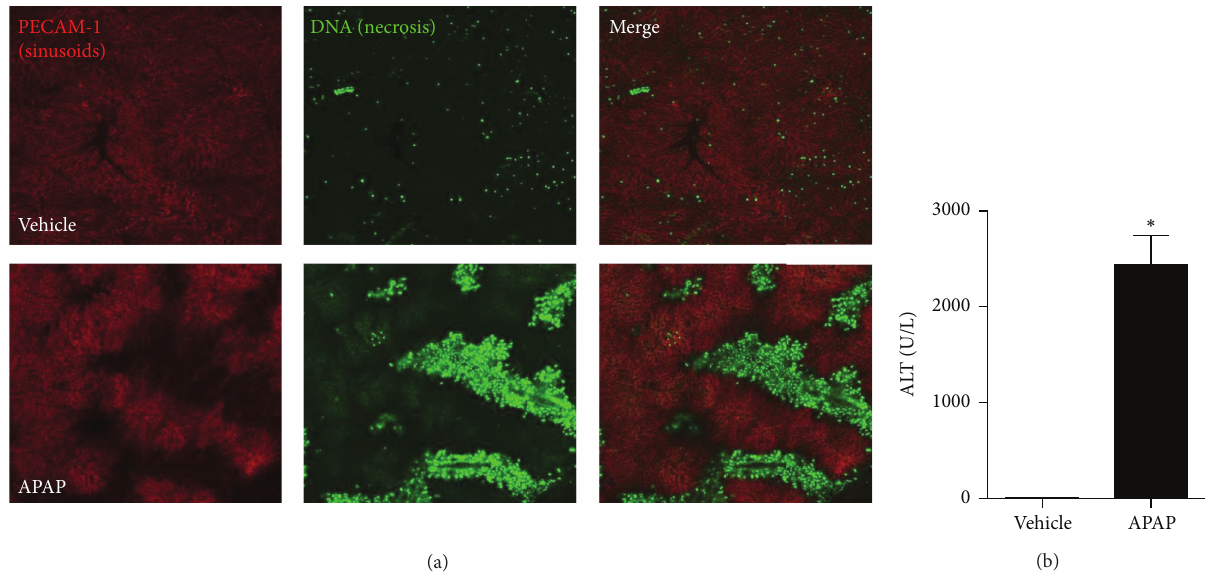
Figure 4: Acetaminophen model of acute liver injury and failure. (a) Liver confocal intravital microscopy showing that while control mice have a well perfused liver vasculature (evidenced by PE-anti-CD31 antibody staining, in red) and absence of necrosis (in green), APAP- treated mice (600mg/Kg) had several dark areas in the red channel, which are suggestive of malperfusion caused by necrosis (elicited by DNA staining using Sytox Green). (b) Serum liver transaminase levels confirmed necrosis. ∗ Statistical significance in comparison to controls ( 𝑃 < 0.05 ). A 10x objective was used during imaging. One-way ANOVA with Tukey’s post hoc test. Data are expressed as mean ± S . E . M ( 𝑛 = 6 mice/treatment).